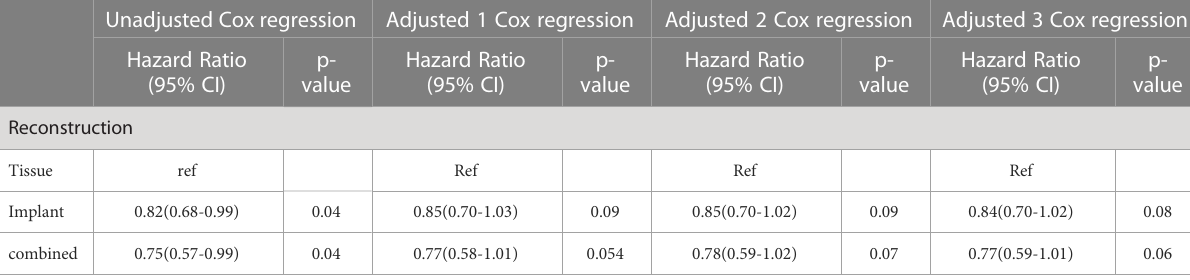
TABLE 5 Hazard ratios of different reconstruction types for all-cause mortality of breast cancer.